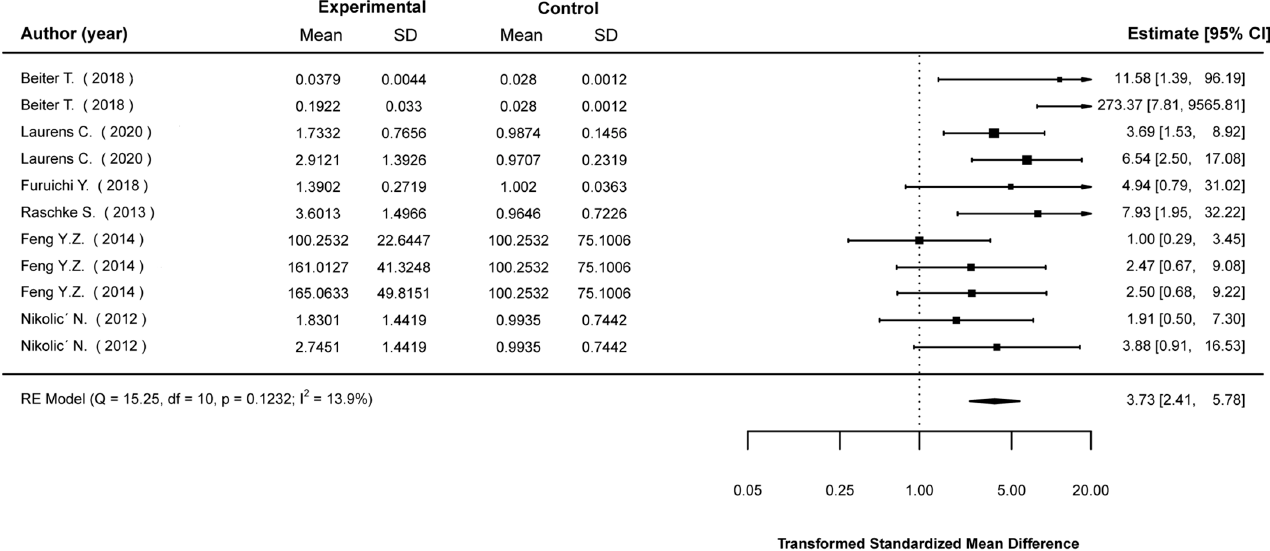
Figure 4. Findings of random-effects meta-analysis on the effects of EPS on IL-6 compared to non- stimulated cells. Results shown are transformed standardized mean differences and 95% confidence intervals, as an estimate of the log odds ratio. Differences greater than 1.00 favour the EPS cells compared to non-stimulated control cells [13,16,20,21,25,41].